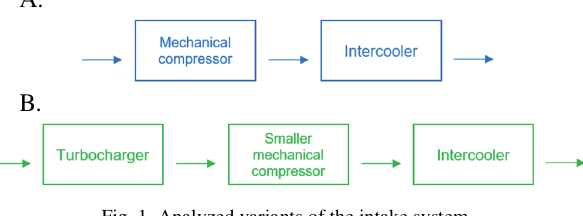
Fig. 1. Analyzed variants of the intake